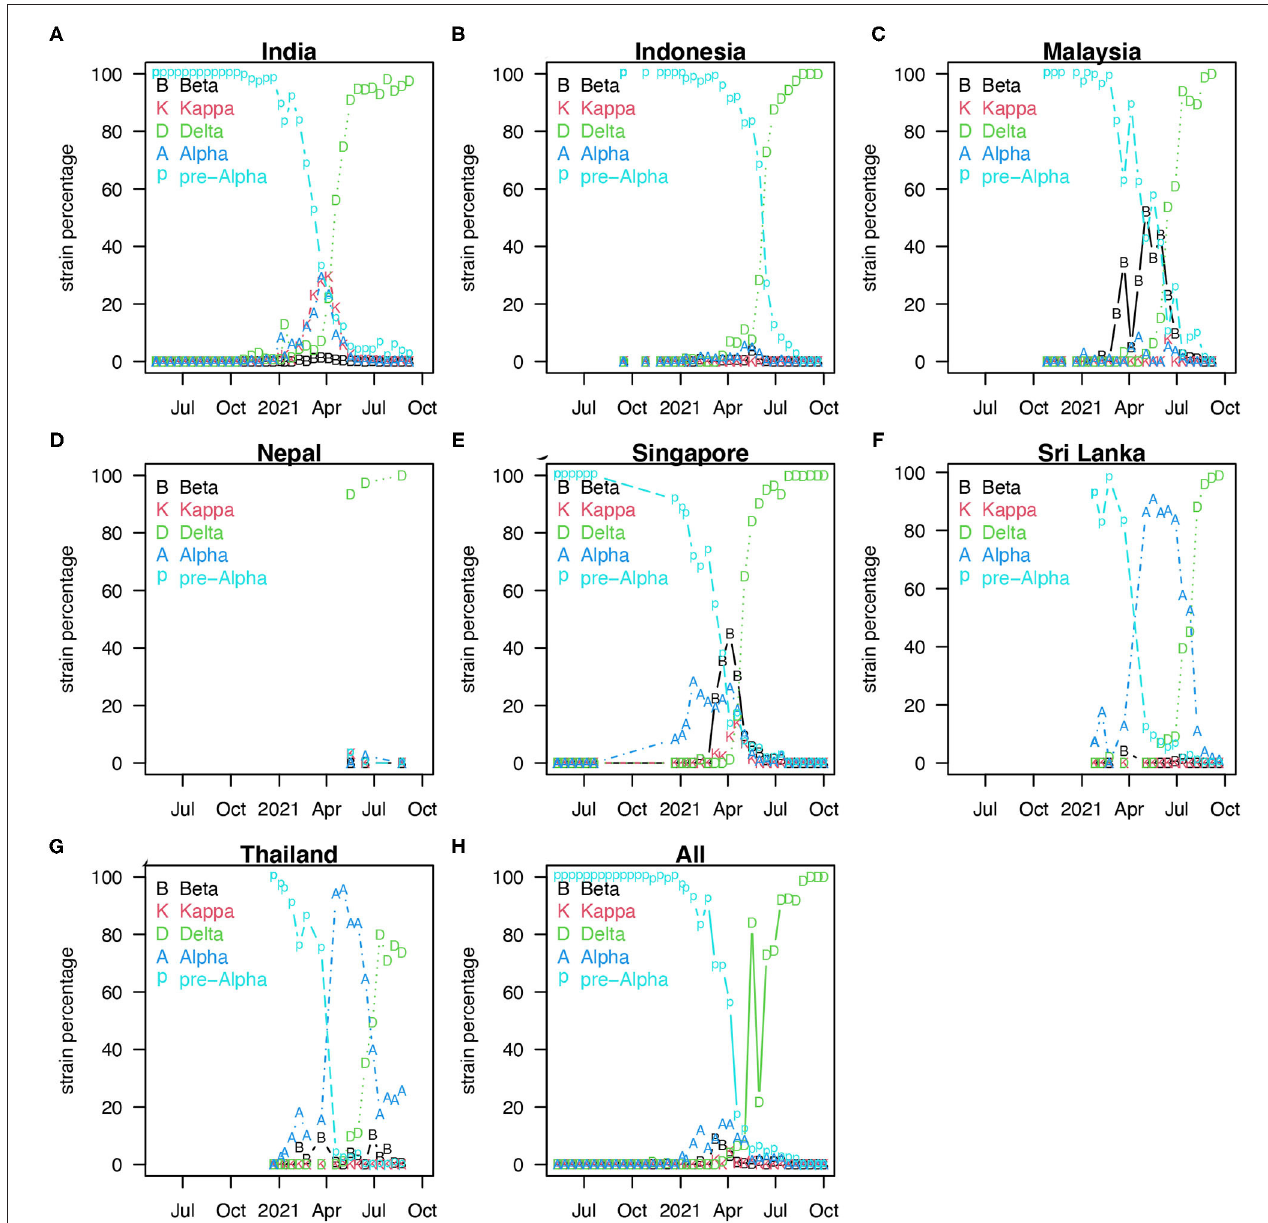
FIGURE 2 | Percentage of strains sequenced biweekly [strain percentage in seven countries of SA and SEA (A–G)] where variants sequenced data are available (8). We only show these strains with a maximum percentage > 20%. (H) Showed the median of strain percentage for each strain sequenced in the seven countries.